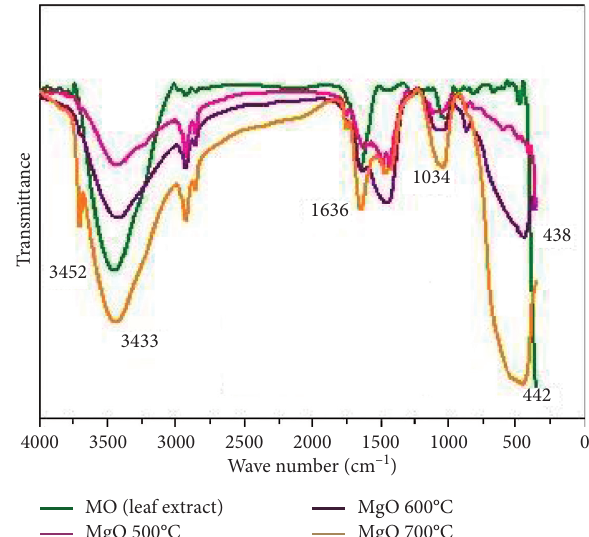
Figure 9: FTIR spectra of calcined MgO nanoparticles and Moringa oleifera leaf extract.